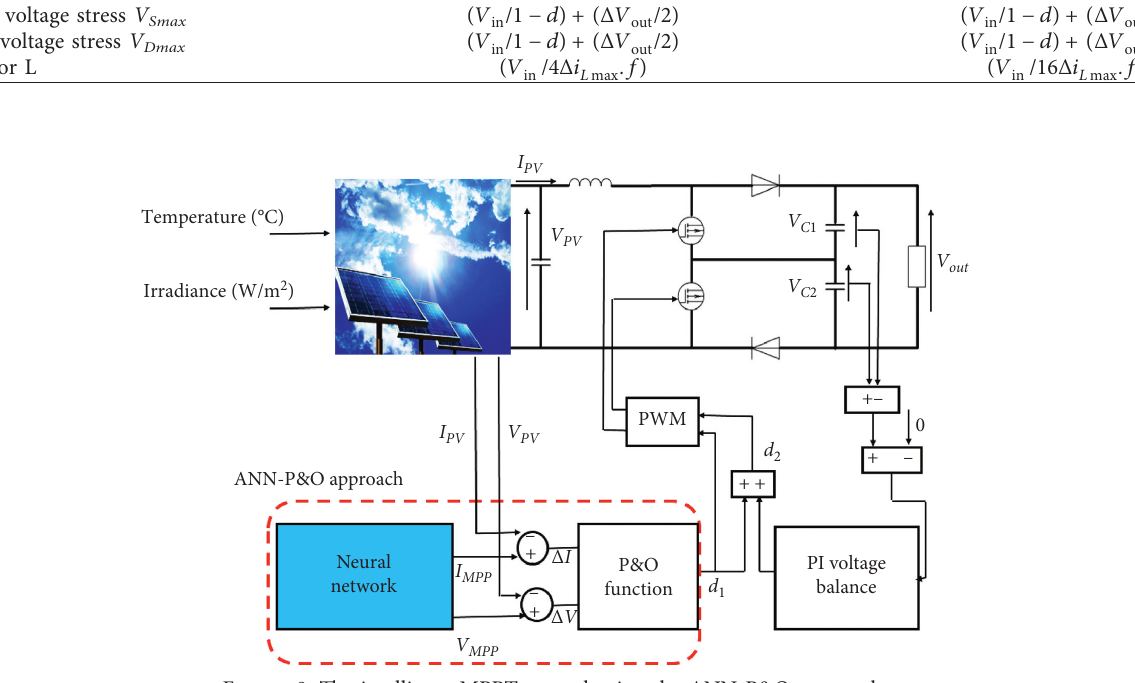
Figure 8: The intelligent MPPT control using the ANN-P&O approach.